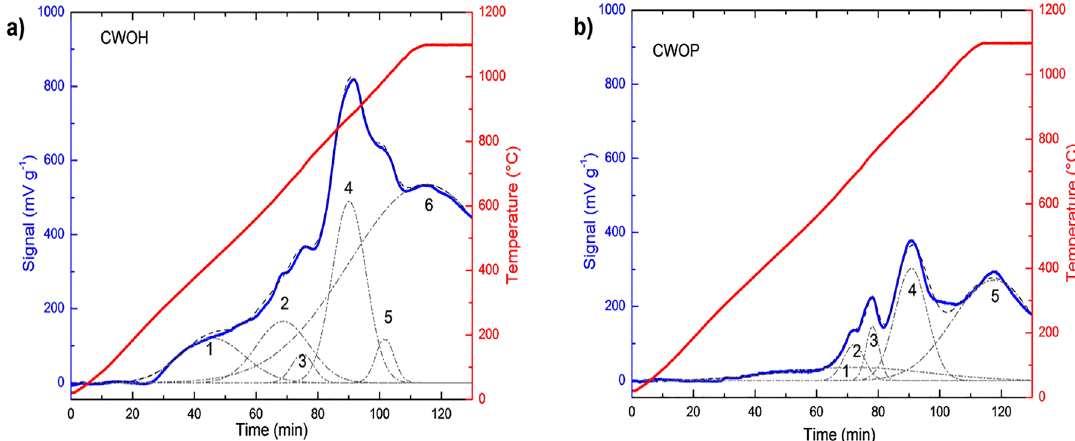
-TPR profiles obtained for CWOH (a), and CWOP Figure 8. H 2